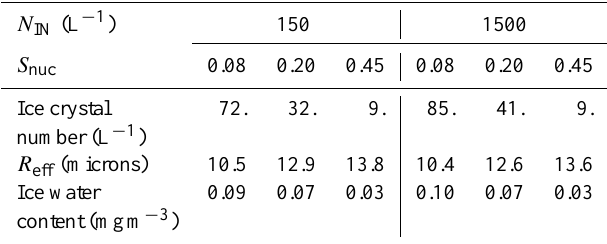
Table 3. Average bulk microphysical properties (ice water content, ice crystal number and effective radius, R eff ) of the simulated cirrus clouds at 15.5km on 28 January, at 10:00, for different choice of the microphysics parameters N IN and S nuc .